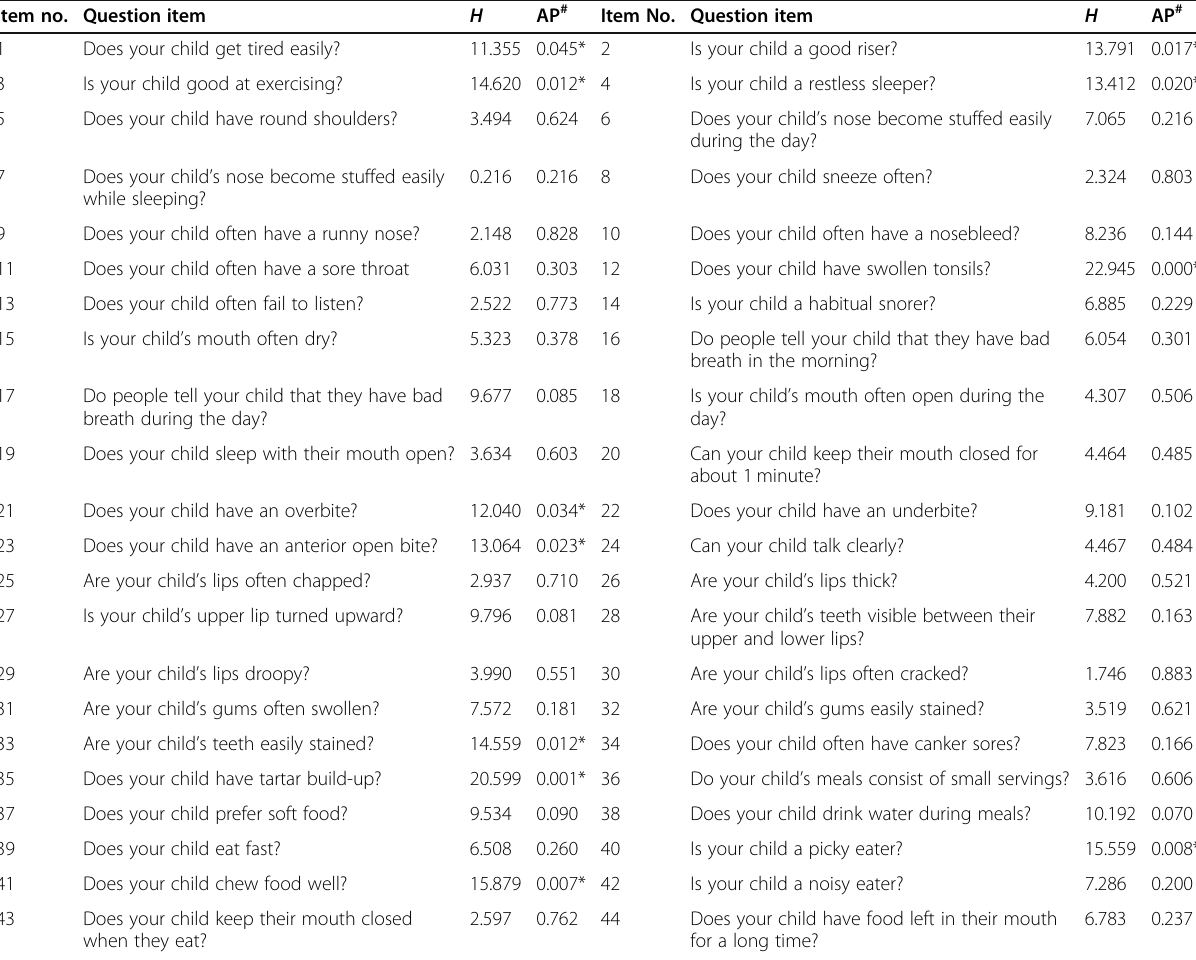
Table 5 Regional differences in all survey question items Item no. Question